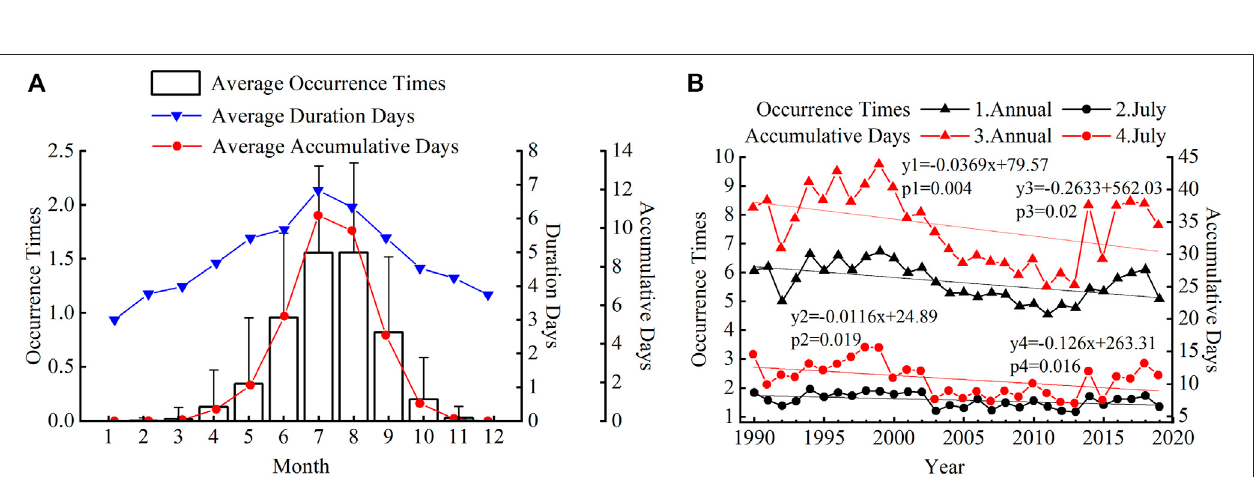
FIGURE 4 | The temporal variations of HTHH events. (A) Variations from month to month. (B) Interannual variations of the HTHH events. Black lines show the variations of occurrence times of the HTHH events; red lines show the accumulative days of the HTHH events; triangles are for annual average HTHH events; and dots show the HTHH events in